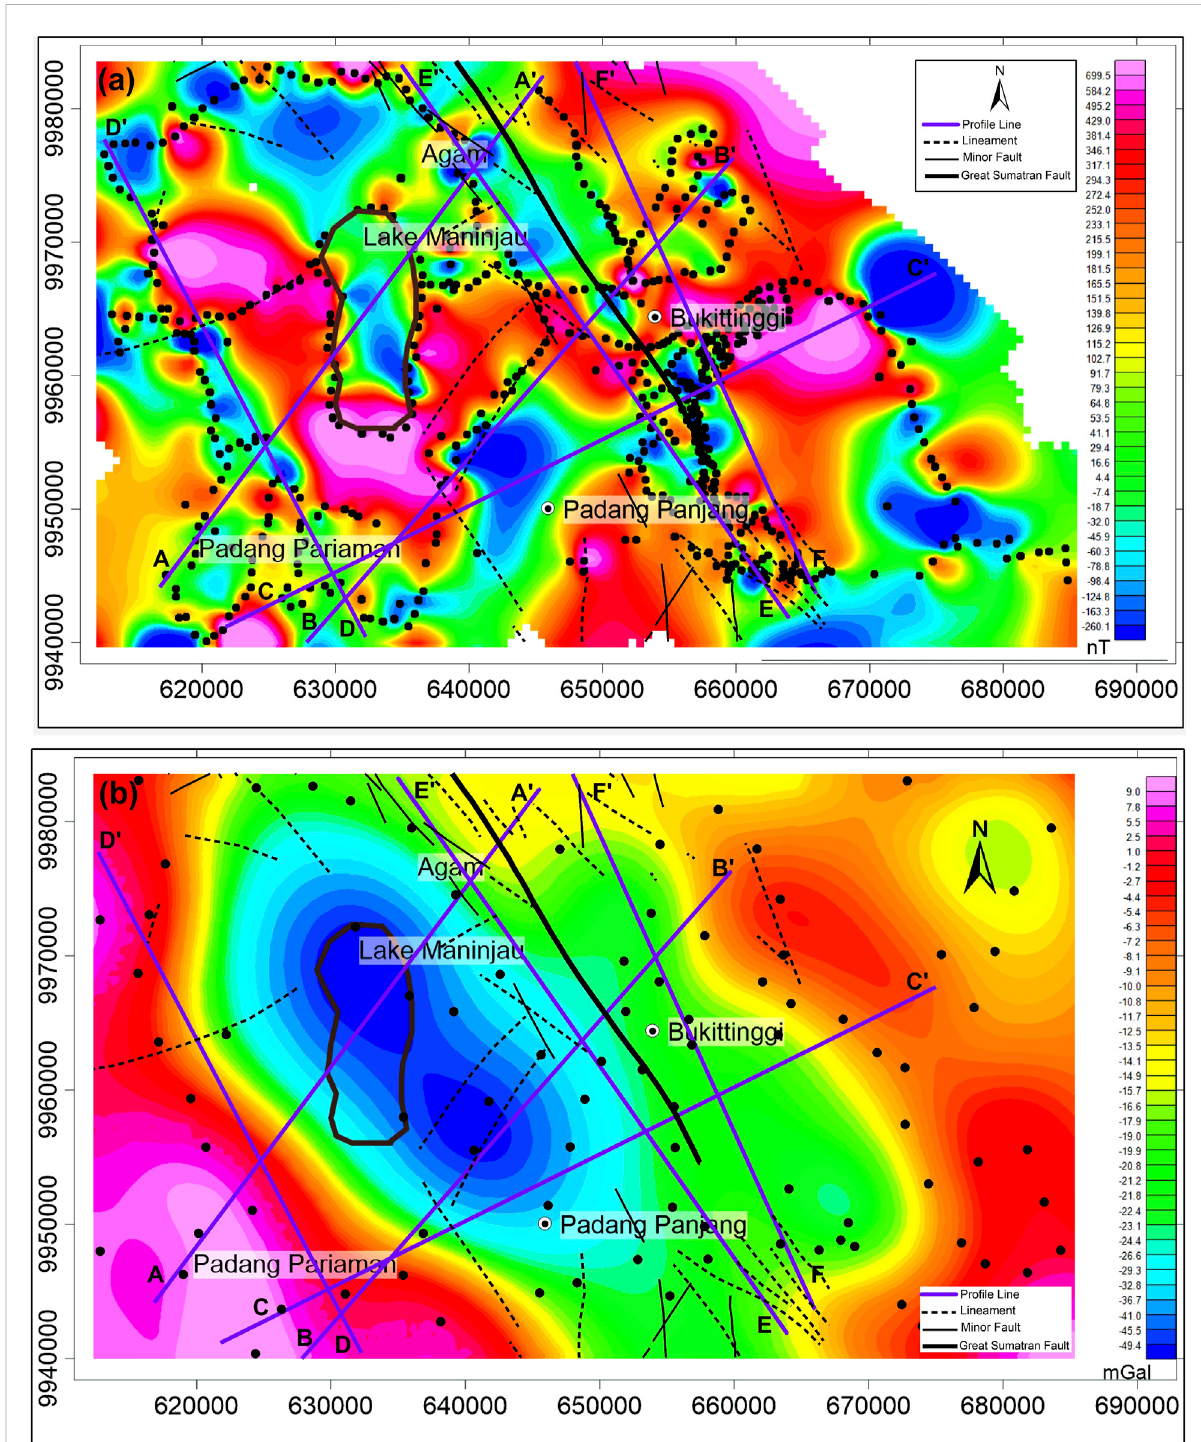
FIGURE 2 (A) The fi lteredmagneticanomalymapoftheSianoksegmentalongwiththesixpro fi lesdiscussedinthisstudy. (B) Agravityanomalymapofthe Sianok segment obtained by digitizing Buyung et al. (1992a; 1992b) Bouguer anomaly maps in the same area as (A) . Black circles are magnetic and gravity survey